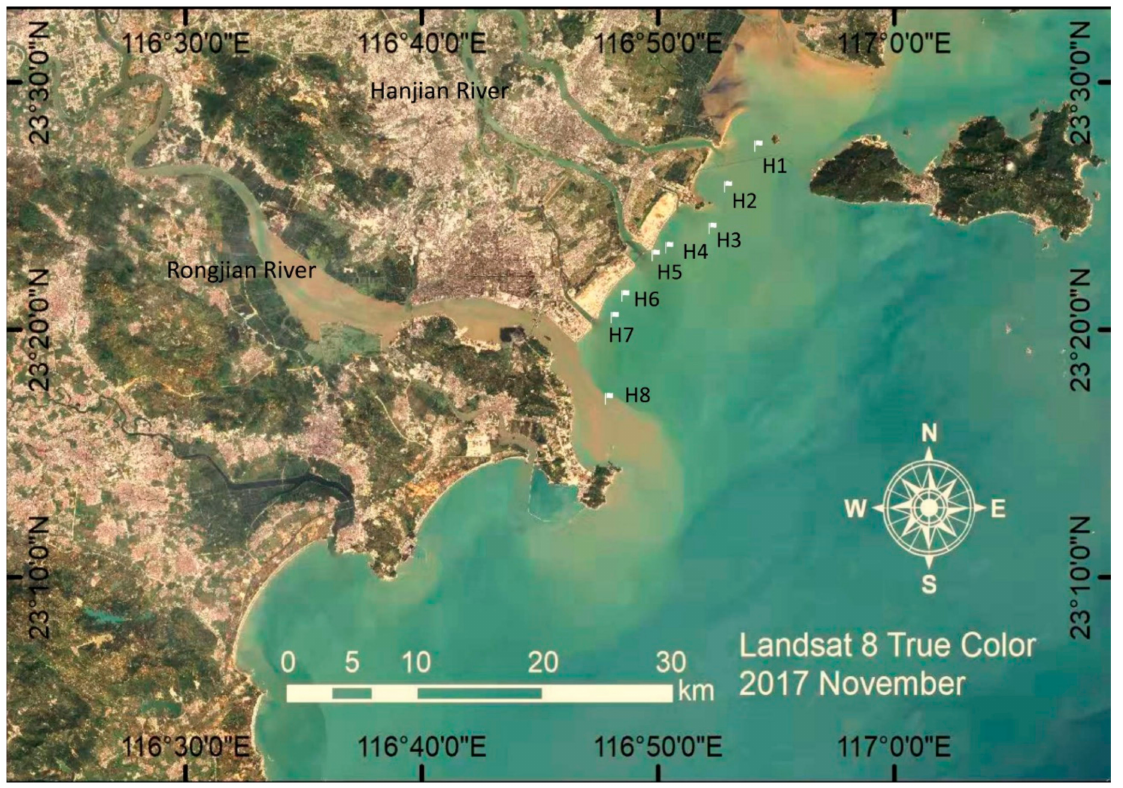
Figure 1. Sampling sites for nearshore sediments along the coastline of Shantou,